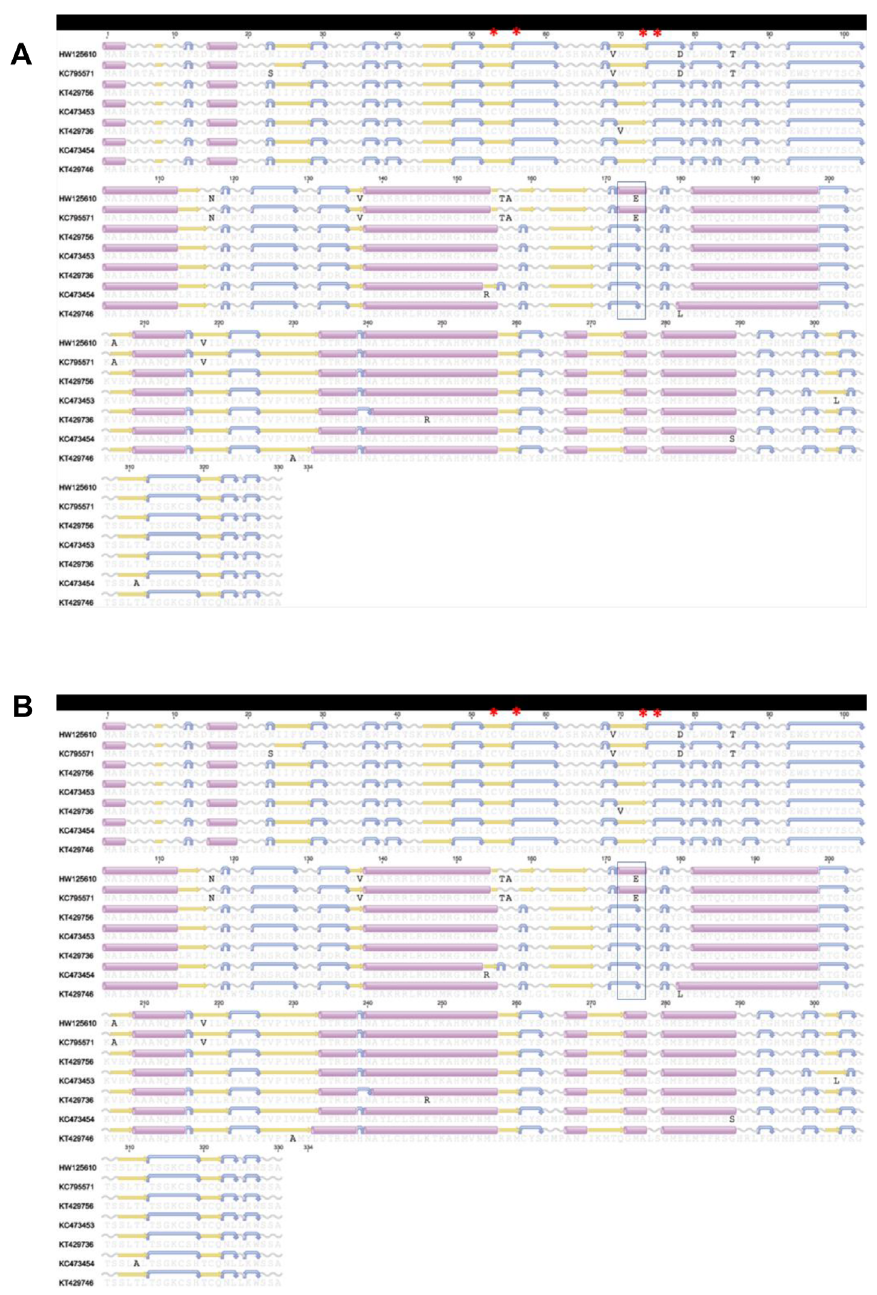
Fig 6. Amino acid alignment of open reading frame consensus sequences encoding the Piscine reovirus σ 3 and μ 1 protein. Secondary structure and transmembrane domains were predicted using EMBOSS 6.6.7 (Geneious software v6.1). Predicted secondary structure of alpha helix, beta strand, coil and turn are presented in purple cylinders, yellow arrows, grey sinusoids and blue curved arrow. Sequences are identified using the GenBank accession numbers. A/ represents ORF sequences encoding PRV σ 3 amino acid alignment. Red stars are conserved Zn-finger motifs. B/ represents ORF sequences encoding PRV μ 1 amino acid alignment. Red cross is myristoylation site in the MRV protein and green line is post-translational cleavage site in MRV and ARV [7].